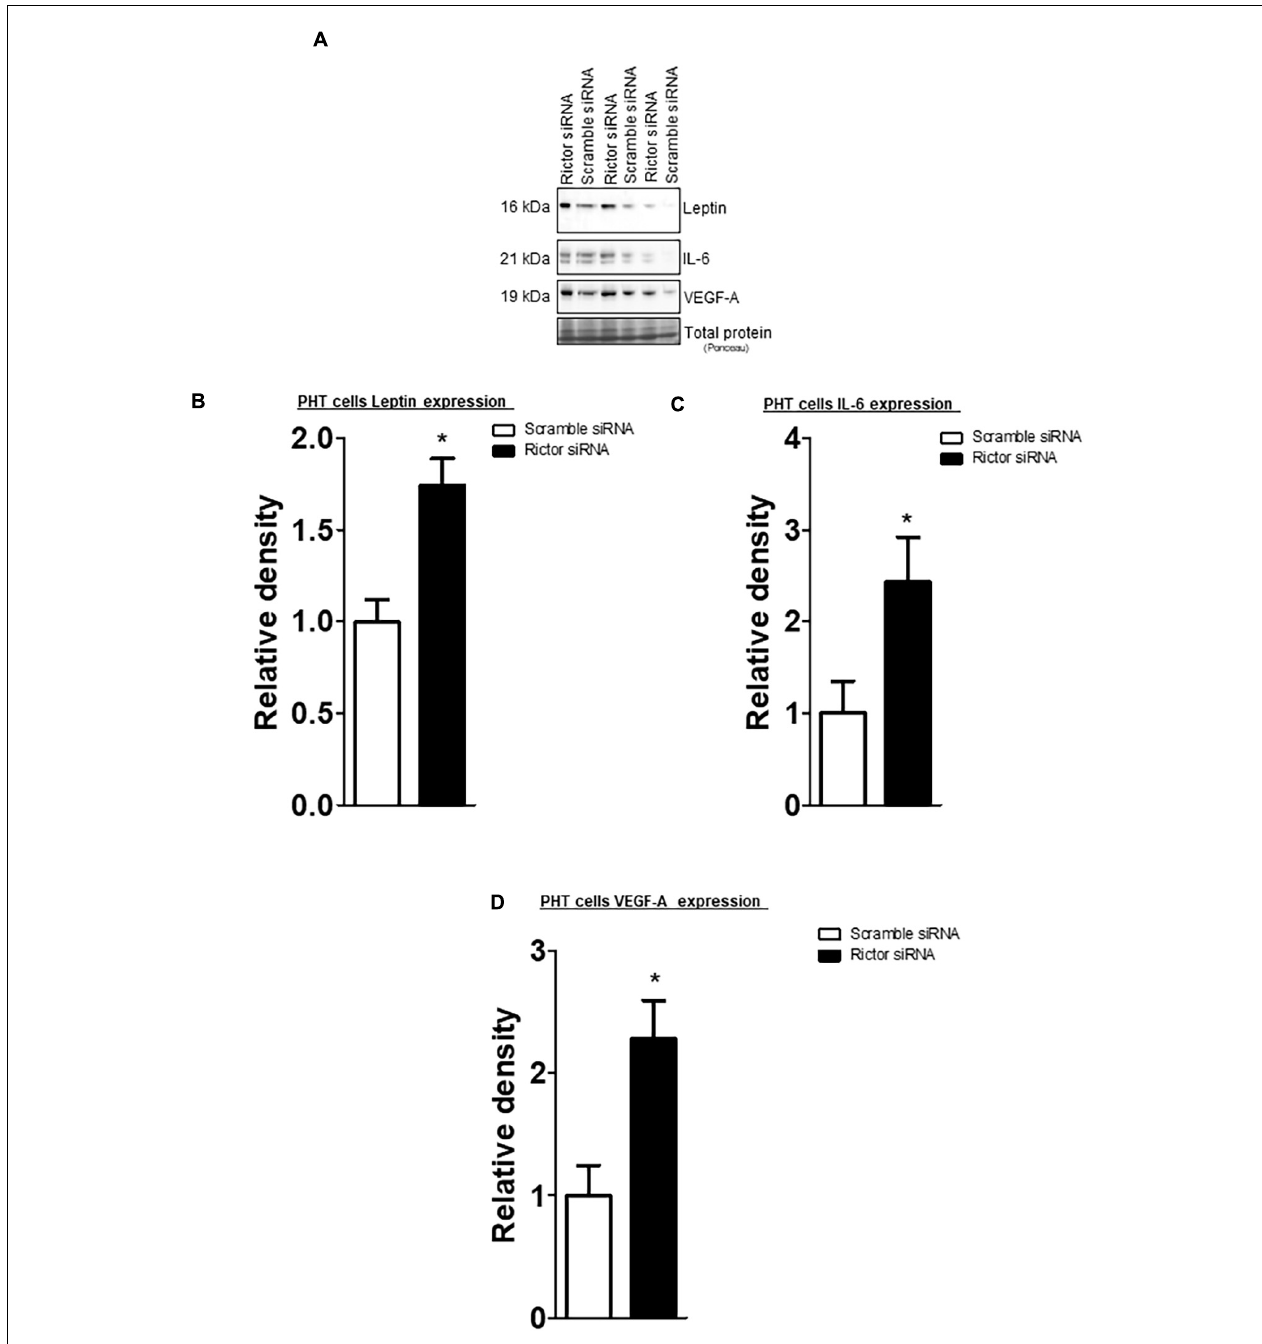
FIGURE 6 | Effect of rictor silencing on leptin, IL-6 and VEGF-A protein expression in PHT cells. (A) Representative western blots of leptin, IL-6 and VEGF-A expression in cell lysates of scramble siRNA and rictor siRNA silenced PHT cells. Equal loading was performed. (B–D) Summary of the western blot data leptin, IL-6 and VEGF-A protein. Values are given as means + SEM. * P < 0.05 vs. scramble siRNA; unpaired Student’s t -test; n = 5/each